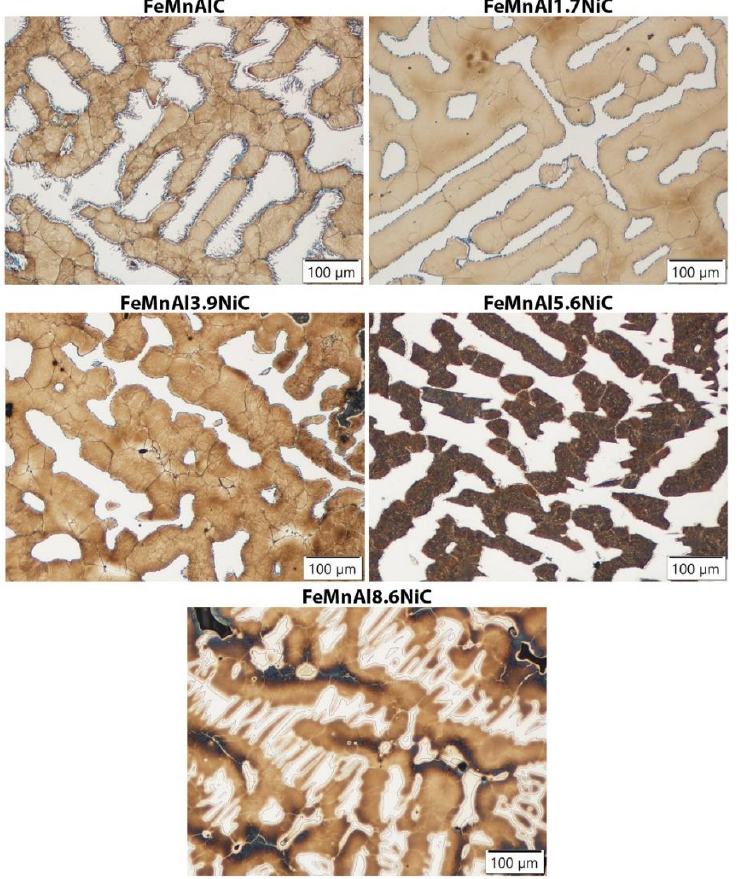
Figure 2. Optical microscopy of Fe-Mn-Al-XNi-C steel as-cast microstructure, with different Ni